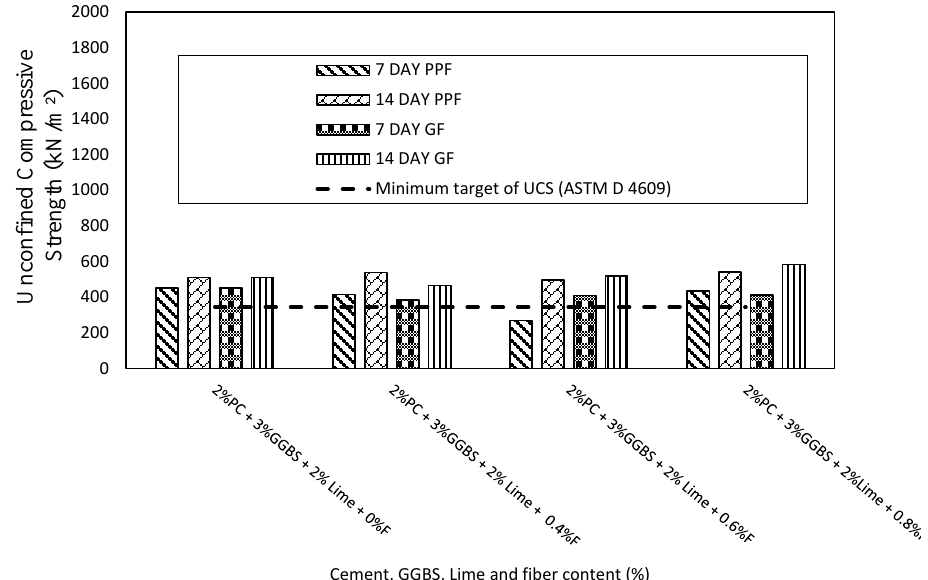
Figure 2. Unconfined compressive strength (UCS) test results for 5%PC and fibre for 7 and 14 days of curing .